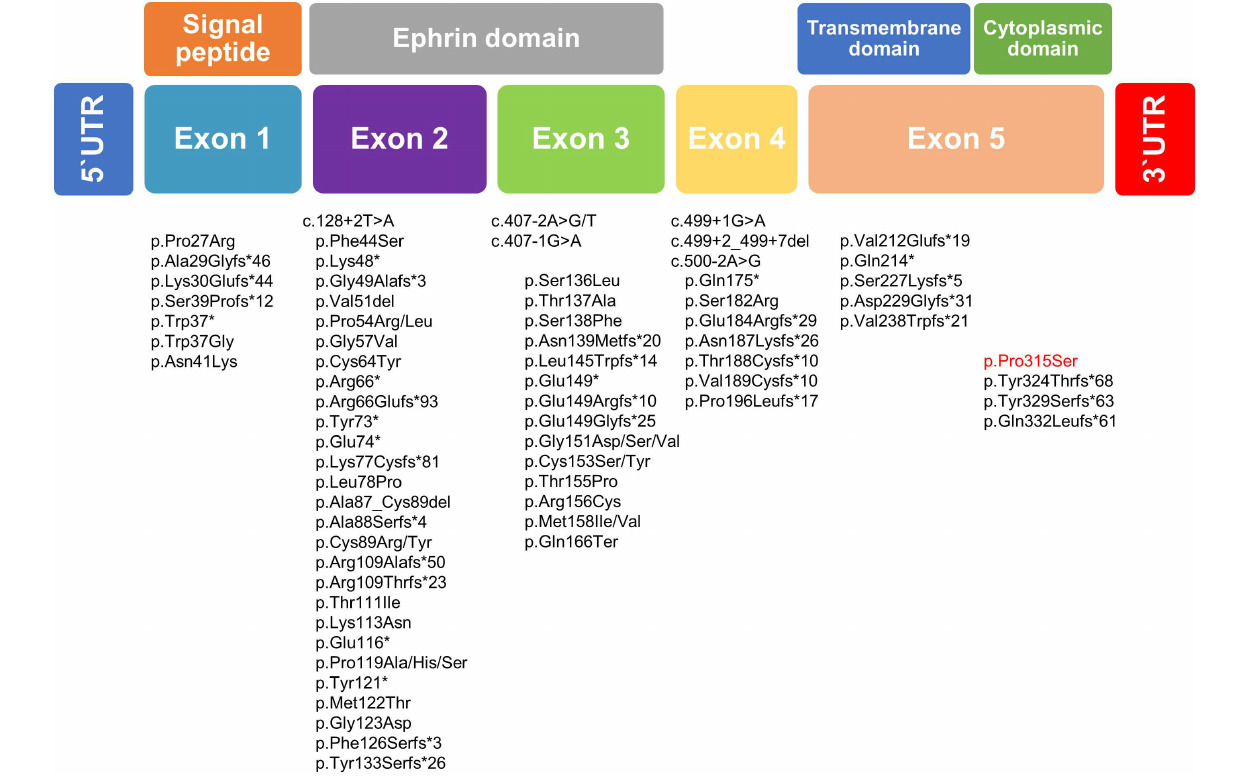
FIGURE 3 | Schematic diagram of the EFNB1 mutation spectrum in patients with CFNS. Below the putative EFNB1 protein structure mutation identified in the present study is highlighted in red, whereas those published previously are written in